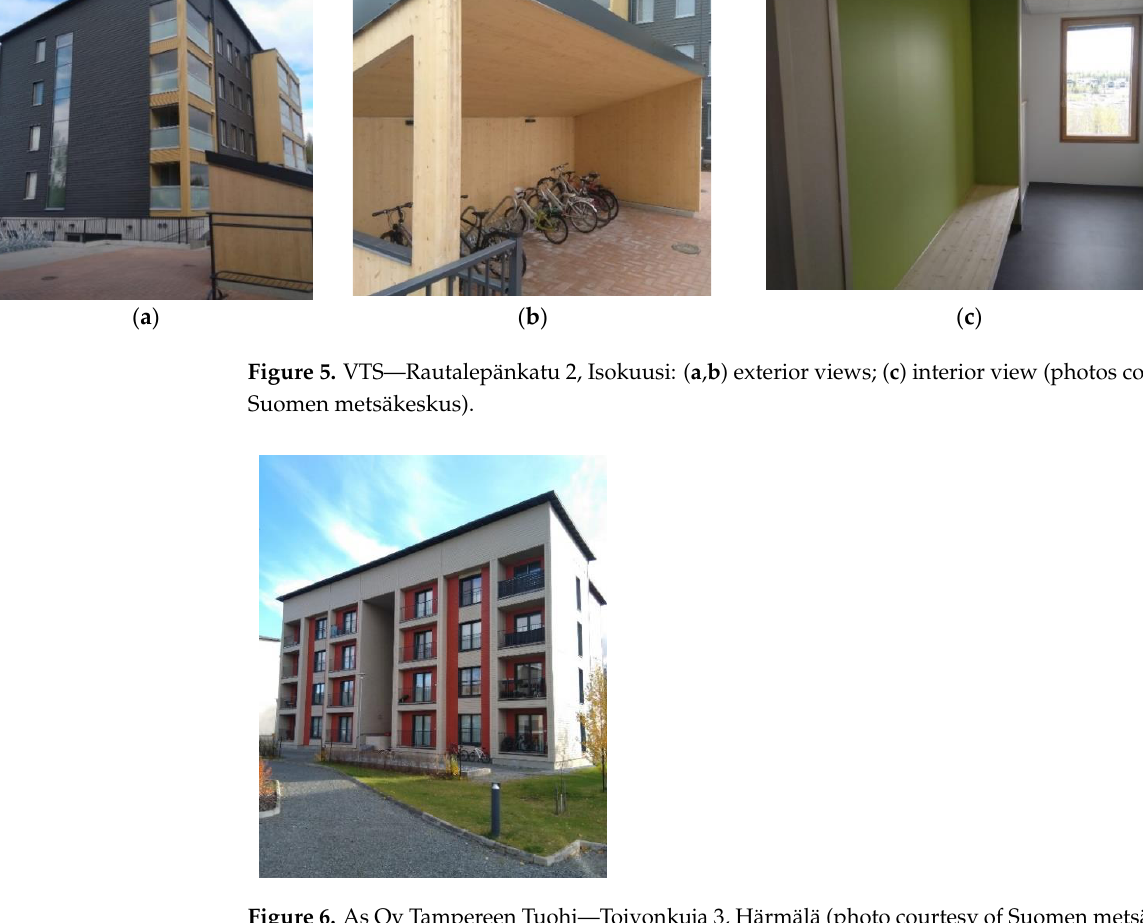
Figure 6. As Oy Tampereen Tuohi—Toivonkuja 3, Härmälä (photo courtesy of Suomen